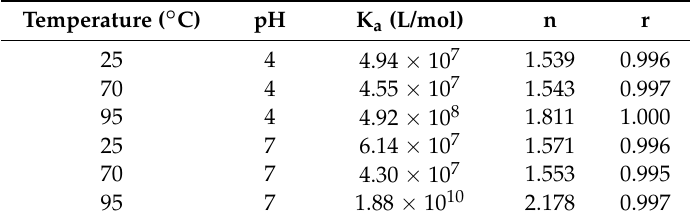
Table 2. The binding constants and binding sites of LF and CA at pH 4 and pH 7.